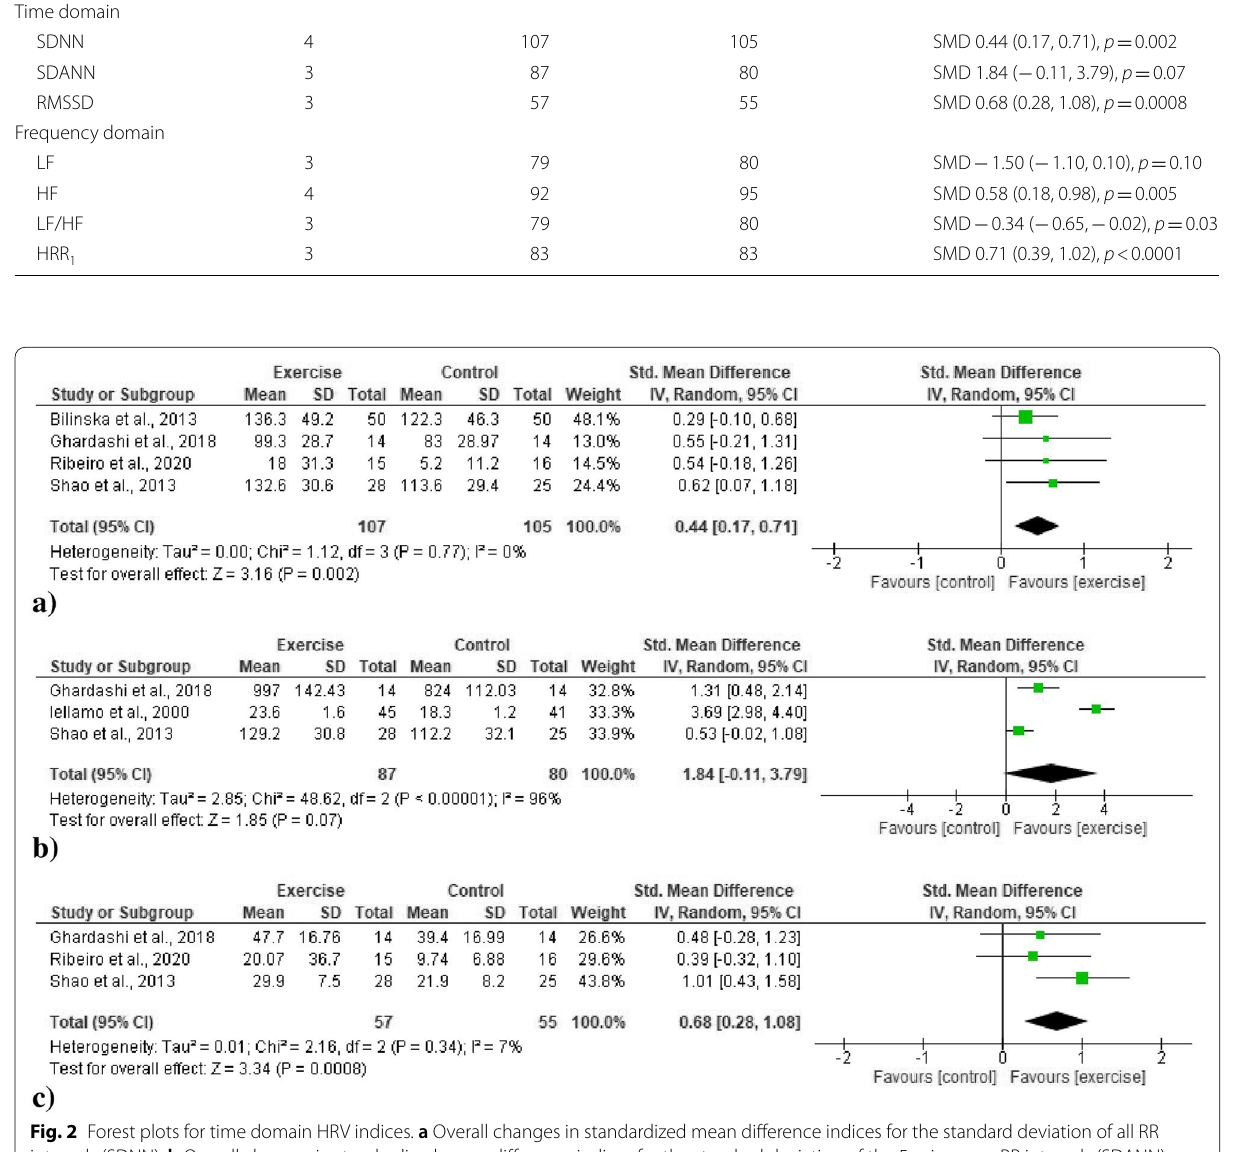
(Fig. 2a). The heterogeneity was statistically non-signifi- cant ( p 0.77), and the inconsistency was low (0%). =